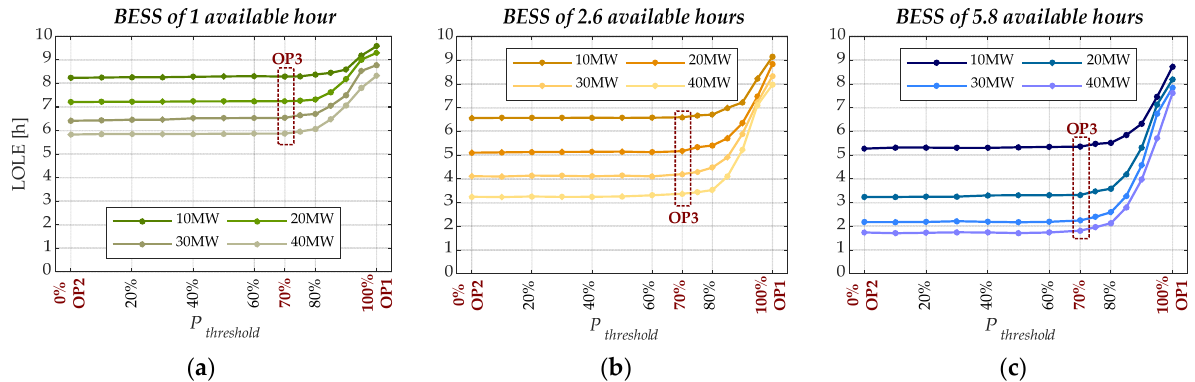
Figure 8. Peak shaving implementation over the year under ( a ) OP2 and ( b ) OP3. The threshold value for OP3 was selected to avoid excessive peak shaving, without sacrificing the resource adequacy benefits from this functionality, as documented by the diagrams in Figure 9. The number of days per year with peak shaving activation for each P threshold is presented in Table 2.